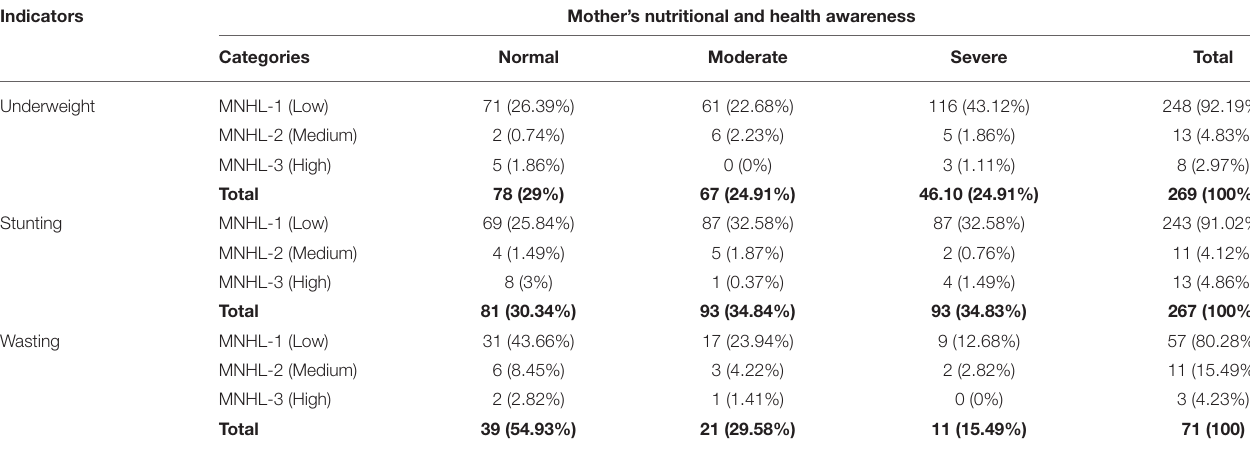
TABLE 3 | Descriptive analysis illustrating the association between mother’s nutritional and health awareness (MNHA) and anthropometric indicators. Indicators